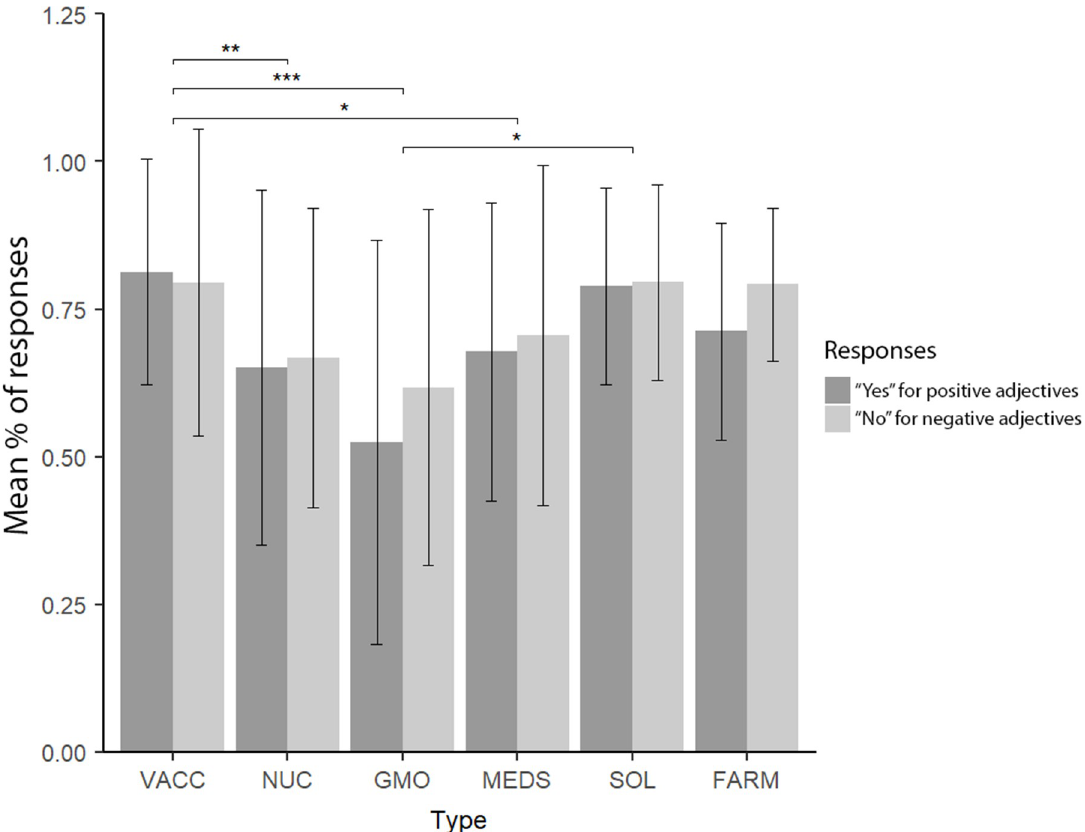
Fig 2. Behavioral responses to categories in the task. VACC = vaccination, NUC = nuclear energy, GMO = GMO technology, MEDS = medicines, SOL = solar energy, FARM = natural farming. The percentage is presented for positive adjectives rated as congruent (“yes”) with a cue and negative adjectives rated as non-congruent (“no”). ��� p < .001, �� p < .01, � p < .05.